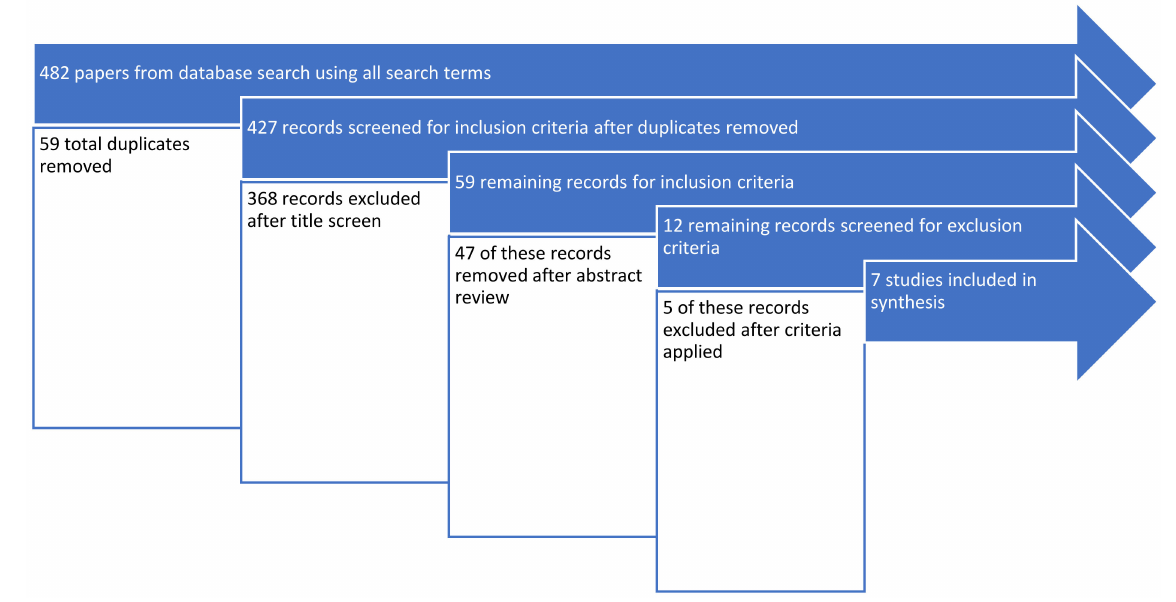
Figure 1. Exclusion process of